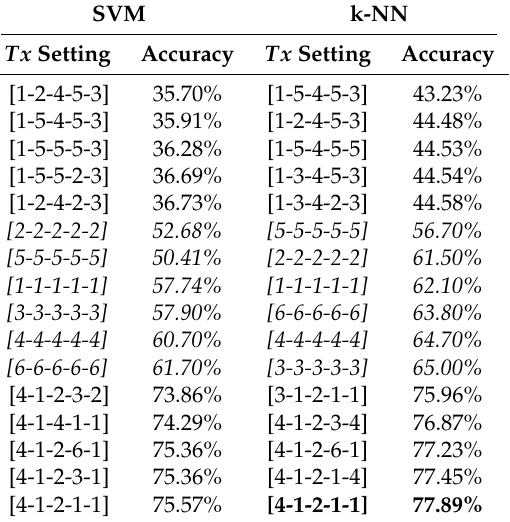
Table 8. Accuracy results for the k-NN using mode (with k = 5) (right) and SVM localization (with a quadratic polynomial kernel function) (left) algorithms. Worst and best settings using different asymmetric transmission power settings, and the best symmetric transmission power level settings (shown in italic font). Best results are shown in bold. SVM k-NN Tx Setting Accuracy Tx